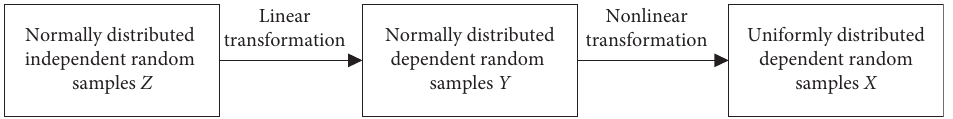
Figure 1: The basic ides of the two-step transformation